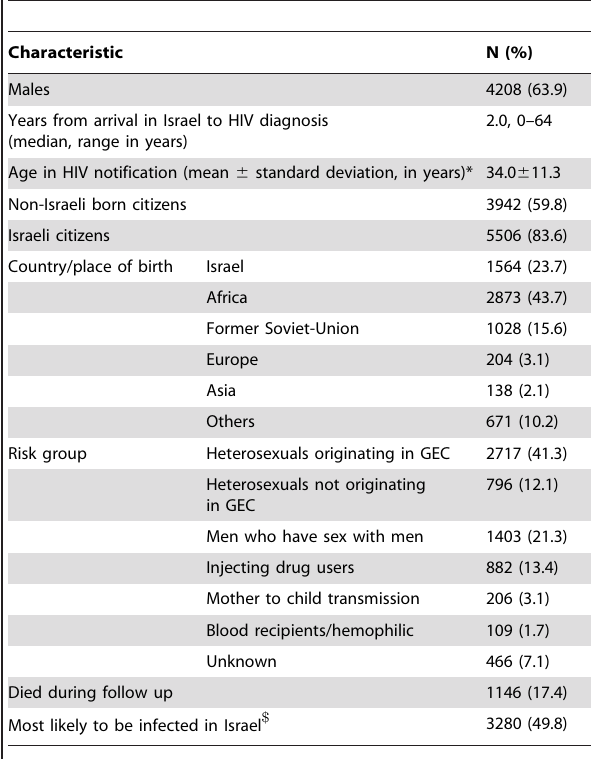
Table 1. Characteristics of all 6582 patients diagnosed with HIV/AIDS in Israel,